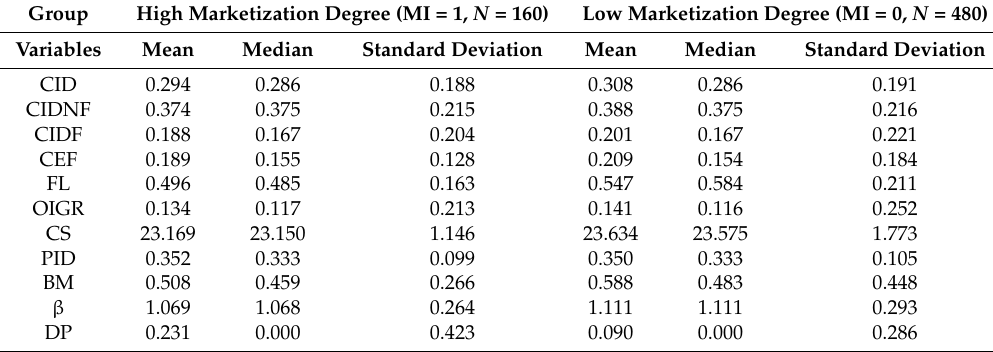
Table 2. Descriptive statistics of different types of carbon information disclosure and other variables under different marketization degree conditions.